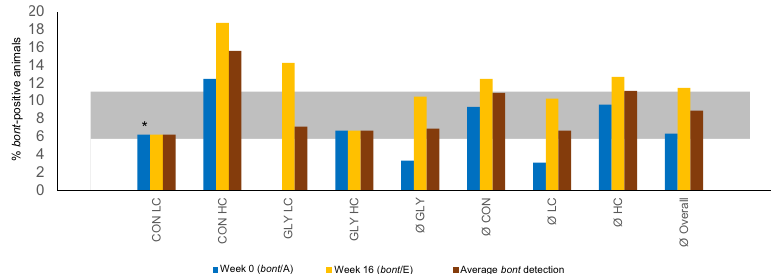
Fig. 8 Detection of C. botulinum neurotoxin (BoNT) gene presence in fecal samples. Depicted are the proportions of bont -positive animals at the beginning of the trial (Week 0, only bont /A, PCR detected) and in week 16 (only bont /E, real-time-PCR detected). Displayed in gray are the average bont -postitive proportions in German cattle herds according to Fohler et al. 36 . CON: groups fed with a control diet, GLY: groups fed with a glyphosate contaminated diet, CFP: concentrate feed proportion, HC: groups with a high CFP, LC: groups fed with a low CFP, *: detection in rumen fl uid, average bont detection: mean of week 0 and week 16, Ø GLY: mean bont -positive animals in GLY groups, Ø CON: mean bont -positive animals in CON groups, Ø HC: mean bont -positive animals in HC groups, Ø GLY: mean bont -positive animals in LC groups, Ø overall: mean bont -positive animals without group